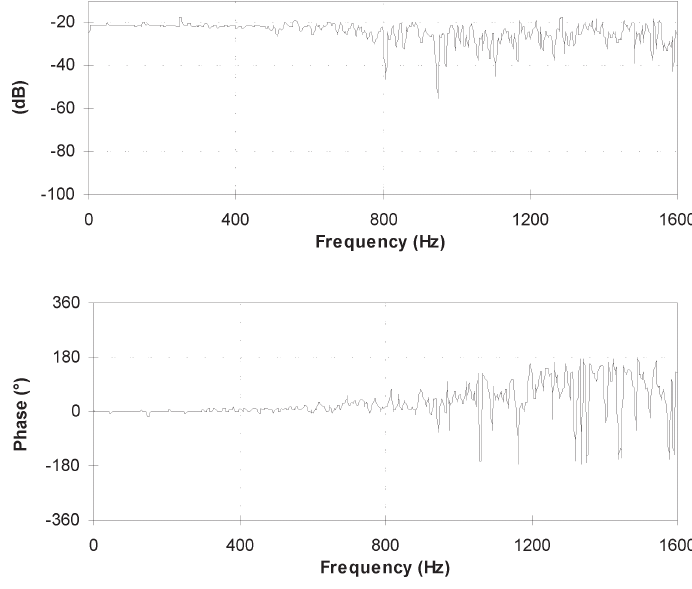
Fig. 5. Frequency response function between the laser interferometer position signal and the PSD output measurement (0–1600